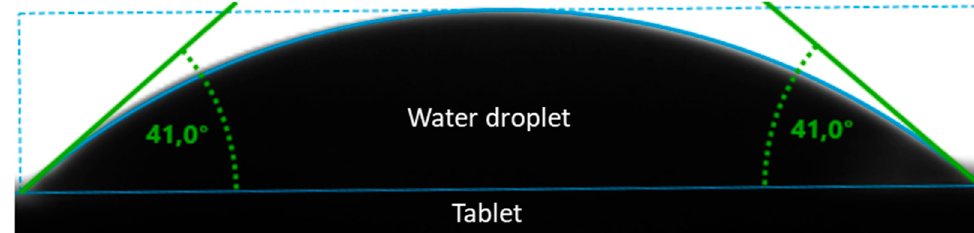
acceleration tension at a working distance of 9.7 mm.